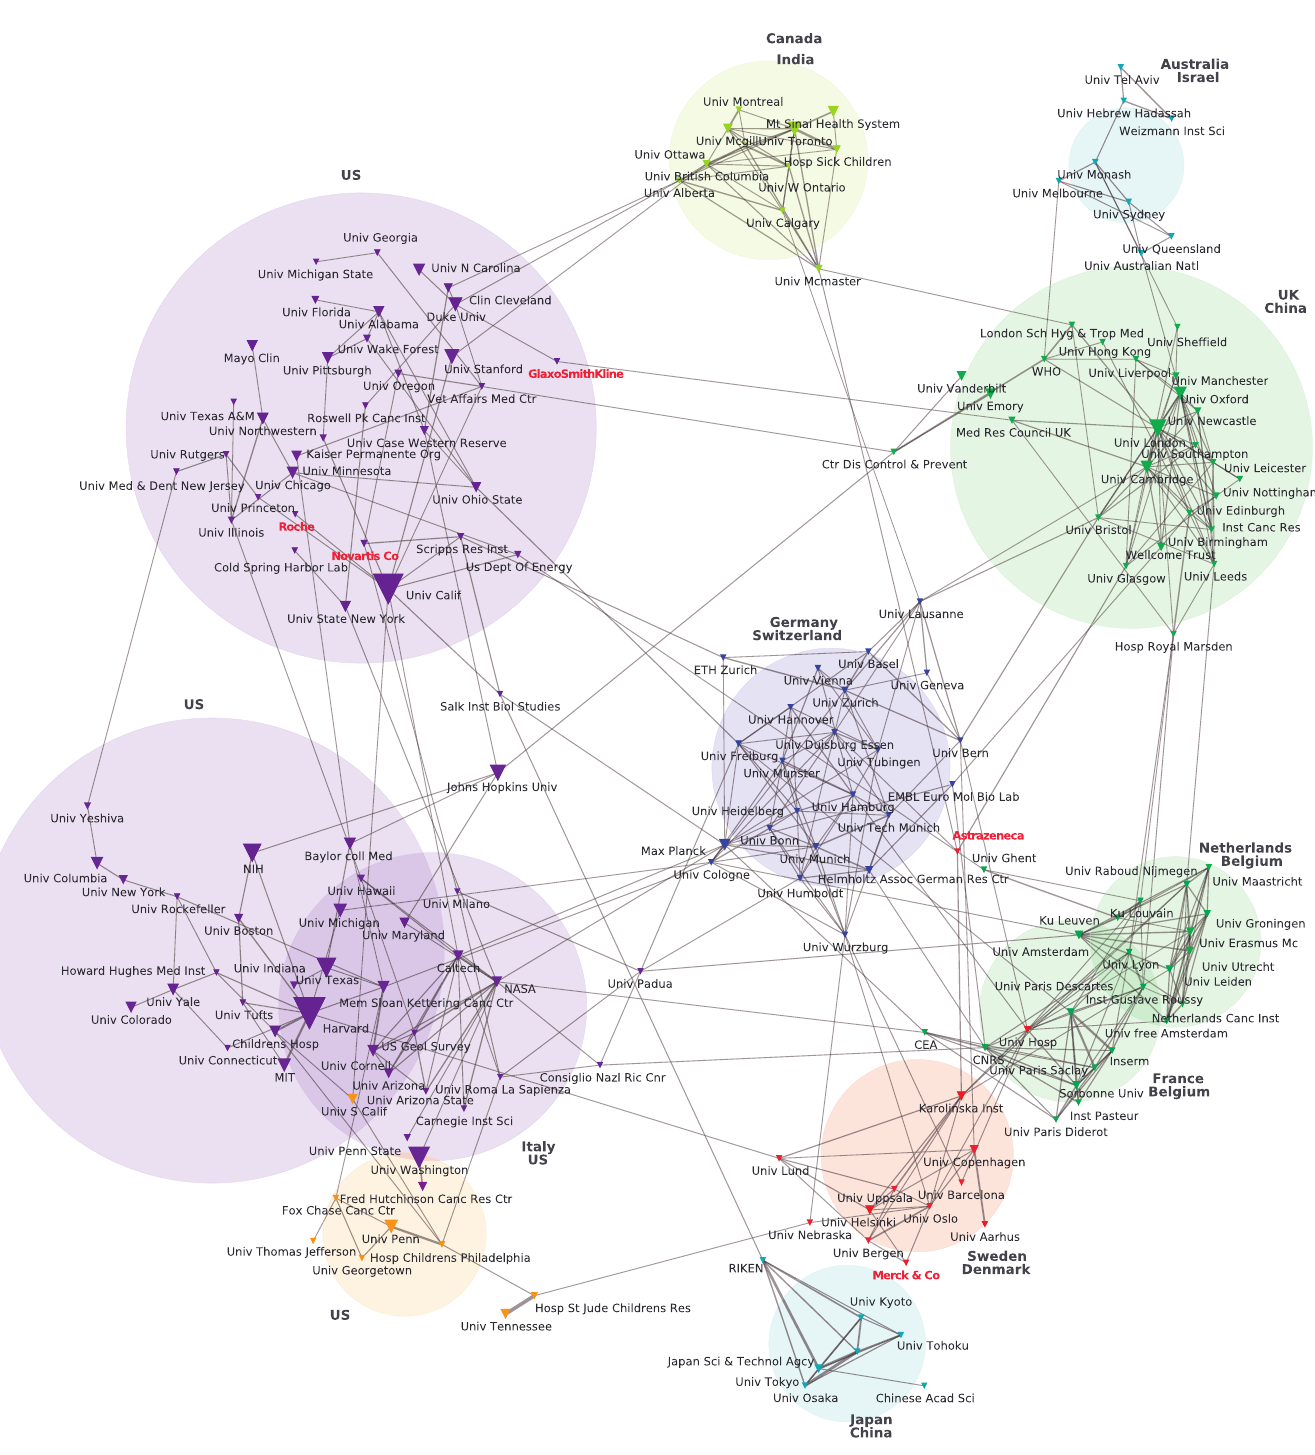
Fig 1. Top 200 health and biomedical sciences (HBMS) research affiliations (1999 to 2008) plotted according to co-authorship using a chi-squared distribution. Source: Authors’ analysis based on Web of Science (WoS) data extraction plotted via CorTexT.